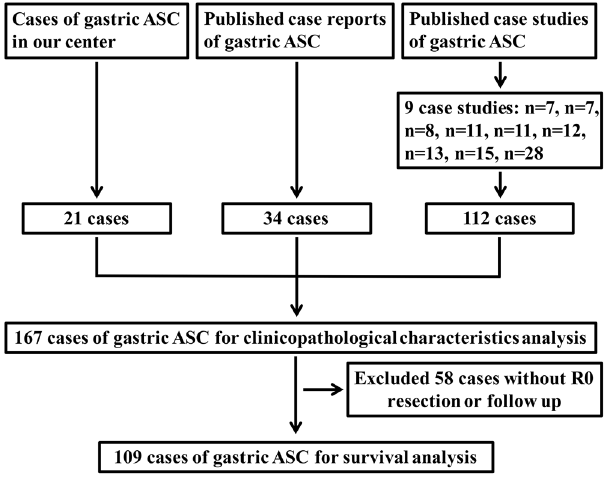
Figure 4. Flowchart of patient